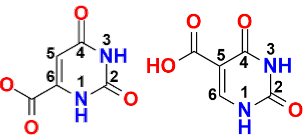
Figure 36. Chemical structures of orotic acid ( left ) and isoorotic acid ( right ).